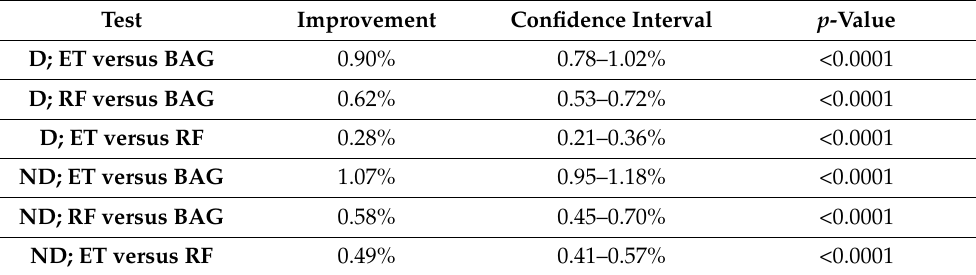
Table 4. Results of applying paired t -test ( α = 0.05) with Bonferroni correction to extracted accuracies using bagged decision trees (BAG), random forest (RF), and extra trees (ET) algorithms (D: dominant hand, ND: non-dominant hand).